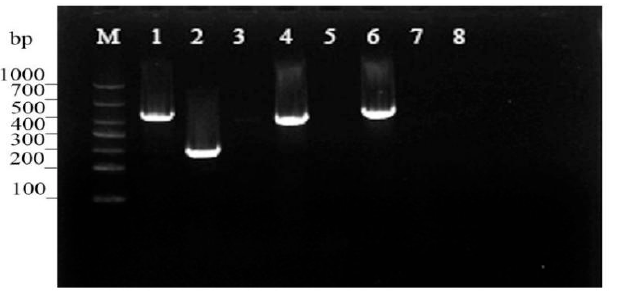
Figure 4. Agarose gel electrophoresis of PCR products of the virulence genes. M: DL1000 marker,